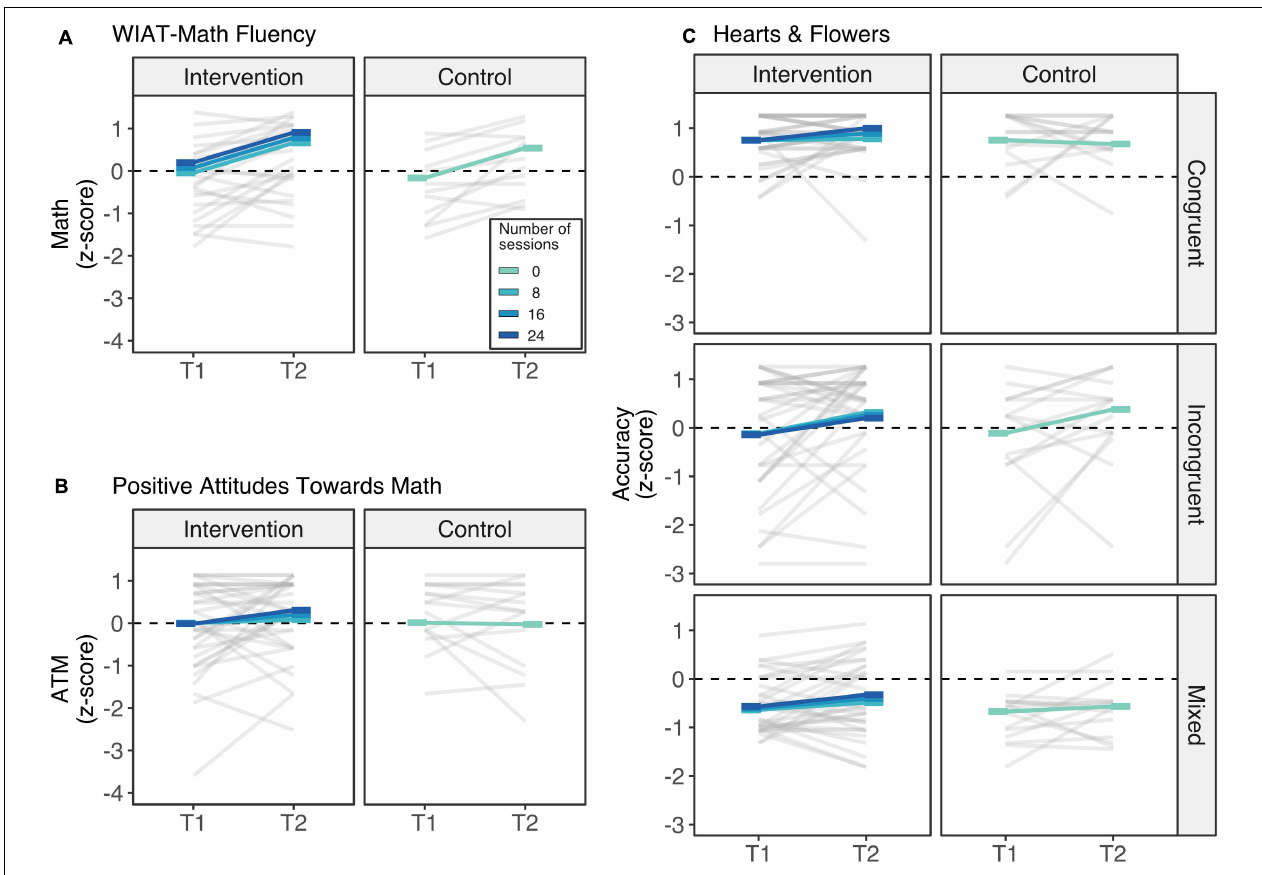
FIGURE 2 | Time 1 (T1) to time 2 (T2) changes in z-scores of the (A) WIAT-III Math Fluency composite scores, (B) Positive attitudes toward math scores, and (C) Hearts and Flowers’ accuracy. Over the five months between time 1 and time 2 and regardless of the number of completed sessions of the intervention, children improved their math skills above and beyond what was expected during this period (A) . While children’s attitudes toward math remained stable from time 1 to time 2 (B) , children also improved their performance in the incongruent block of Hearts and Flowers tasks (C) . Rods represents the estimated marginal means across different number of sessions of attendance from 0 sessions (control group) to 24 sessions (darkest